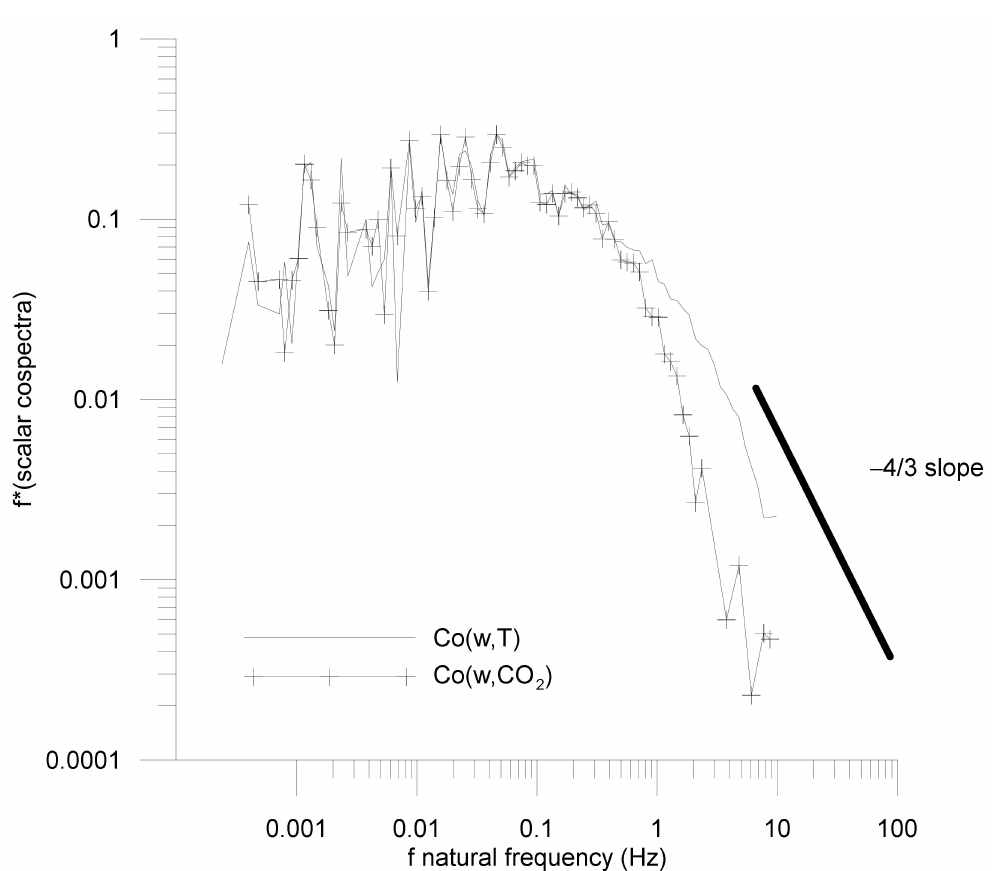
Figure 4. Normalized averaged cospectra (ratio of cospectra over covariance) of sensible heat fluxes, Co (w,T ), and of CO 2 , Co( w , CO 2 ) over a 4 h period (from 11:00 to 15:00, with U from 2.15 to 2.85 m s − 1 and z/L ranging from − 0.203 to −